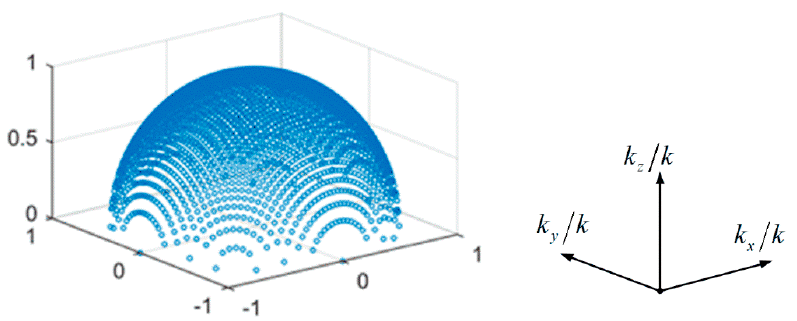
Figure 2. Constellation of the propagation group in the k -space.